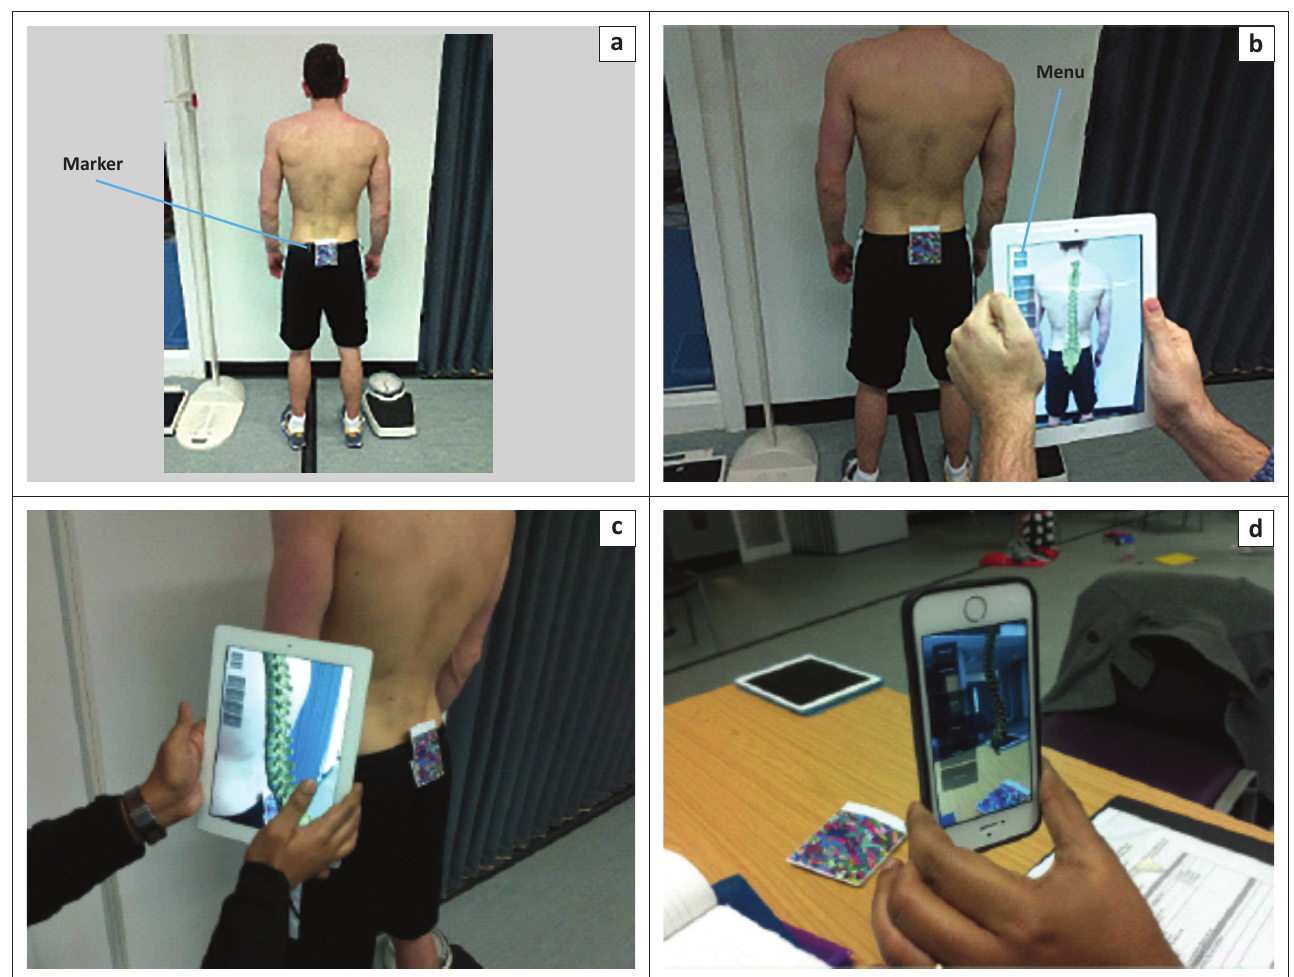
FIGURE 3: Learning using the vision-based augmented reality mobile